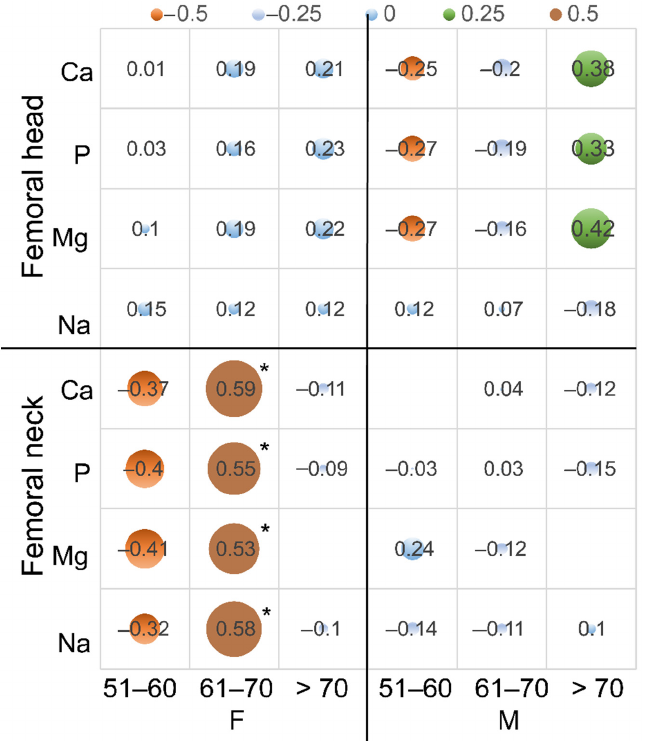
Figure 5. The bubble chart is a variation of Spearman’s correlation coefficient for the content of Ca, P, Mg, and Na with the BMI in the femoral head and neck and age in the age groups. An additional dimension of the data is represented in the size of the bubbles; *: statistically significant.